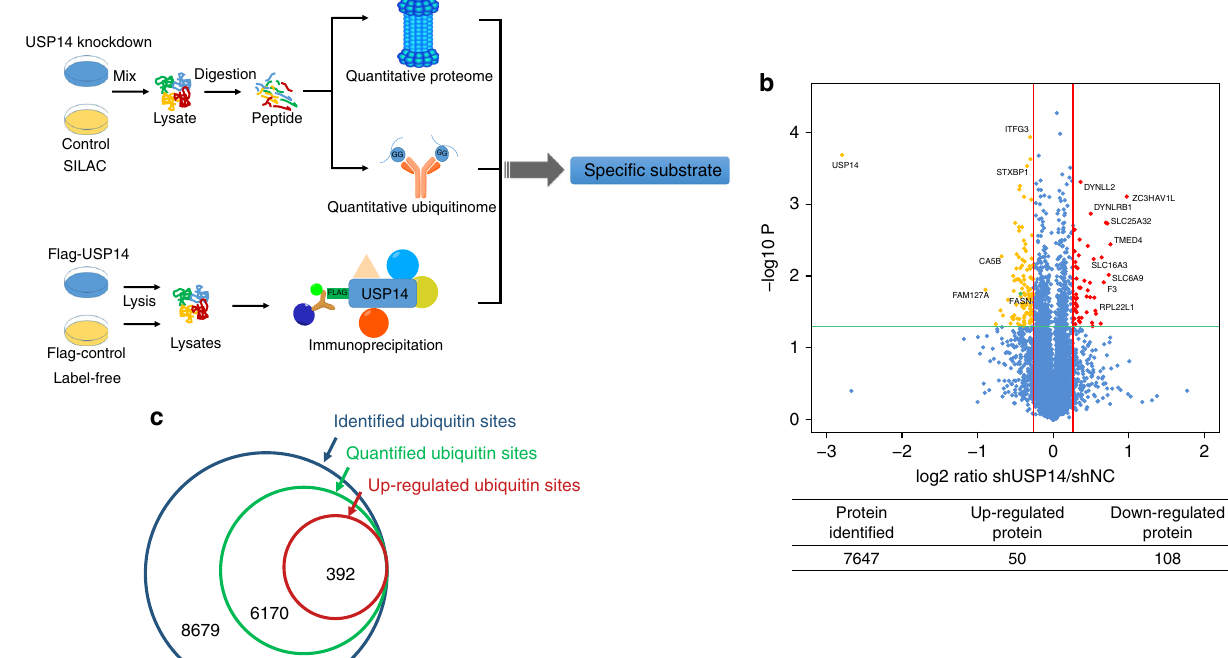
Fig. 2 Quantitative proteomic pro fi ling for USP14 regulated proteins and interaction components. a The diagram shows the experimental process for the quantitative proteomics, ubiquitinome, protein – protein interaction analysis of USP14. b Volcano plot of the protein abundance changes in response to USP14 KD. Average protein expression ratio of 4 replicates (log 2 transformed) between USP14 knockdown and wild-type HeLa cells was plotted against p -value by t -test ( − log 10 transformed). Cutoff of p = 0.05 and 1.2-fold change were marked by green and red lines, respectively. The fi gure below shows the total number of proteins identi fi ed as well as the number of up- and downregulated proteins. The detailed information on protein groups is listed in Supplementary Data 1. c Number of identi fi ed ubiquitin sites, quanti fi ed ubiquitin sites, and upregulated ubiquitin